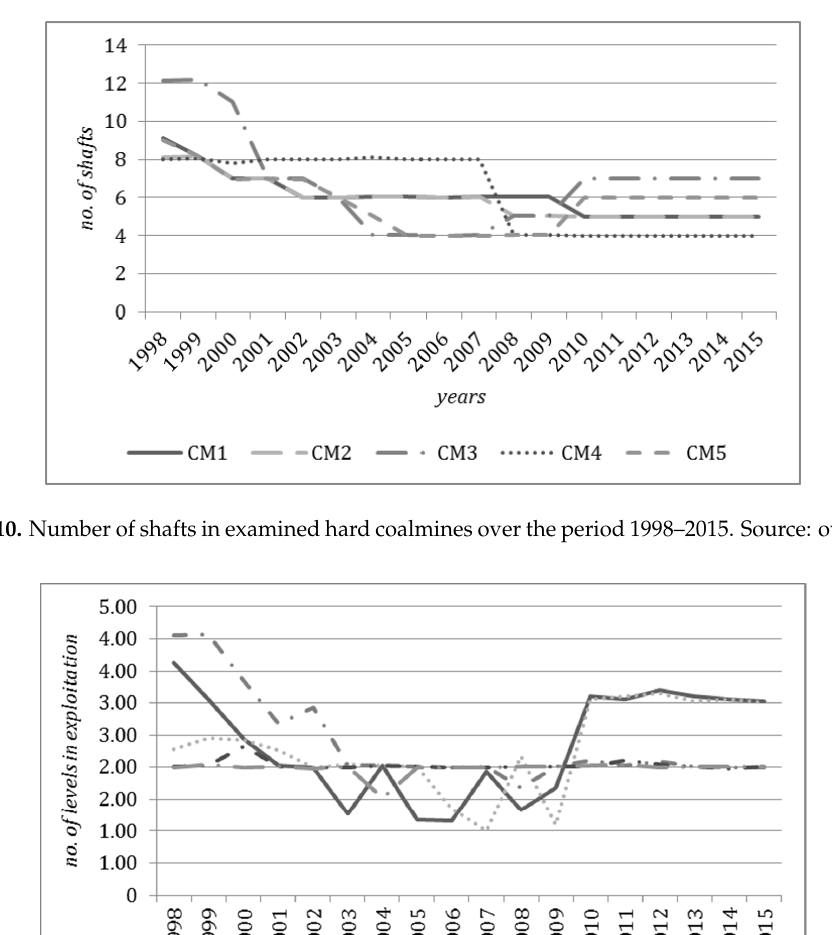
Energies 2017 , 10 , 1480 12 of 22 2009, the number of layers in exploitation rapidly increased in CM1, CM2, CM3 and CM4 (Figure 12). All observable changes in infrastructure confirmed the development of the highest performing Polish hard coalmines and that investment in their expansion should ensure the survival of the Polish hard coalmining industry. In summary, all examined hard coalmines exhibited decreasing production and employment. Additionally, they were limiting aboveground and underground infrastructure wherever it was unnecessary to maintain and develop planned hard coal production capacity. Investments were (and are) obtained by the hard coalmines characterized by the highest production efficiency and the